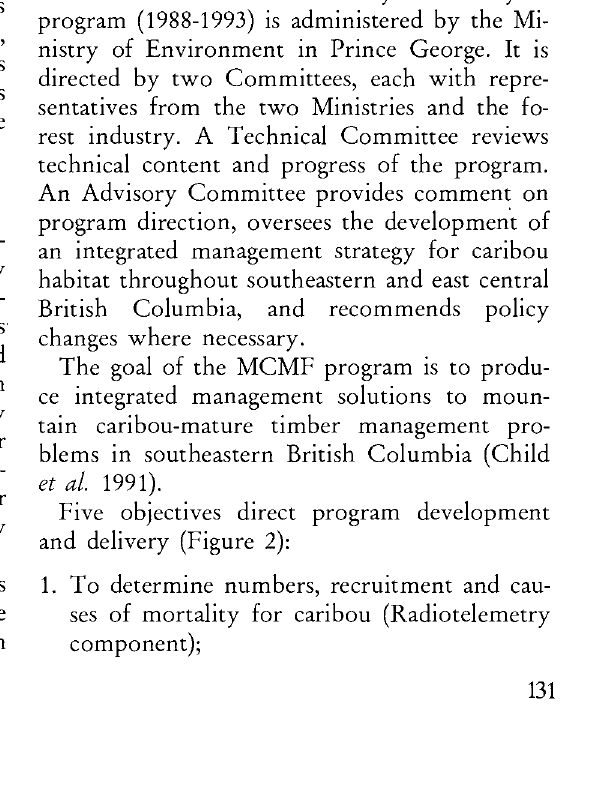
Figure 1. Location of the intensive and extensive stu dy areas of the M C MF